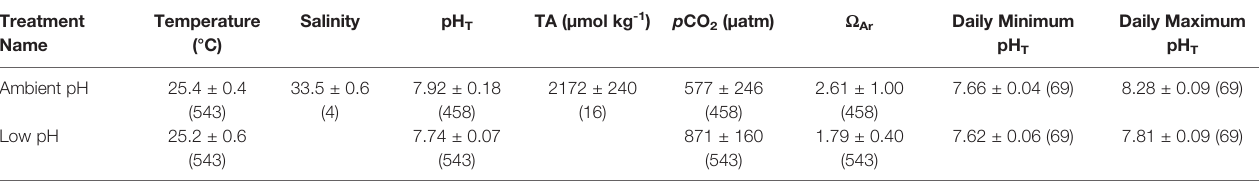
TABLE 1 | Seawater chemistry in the two experimental